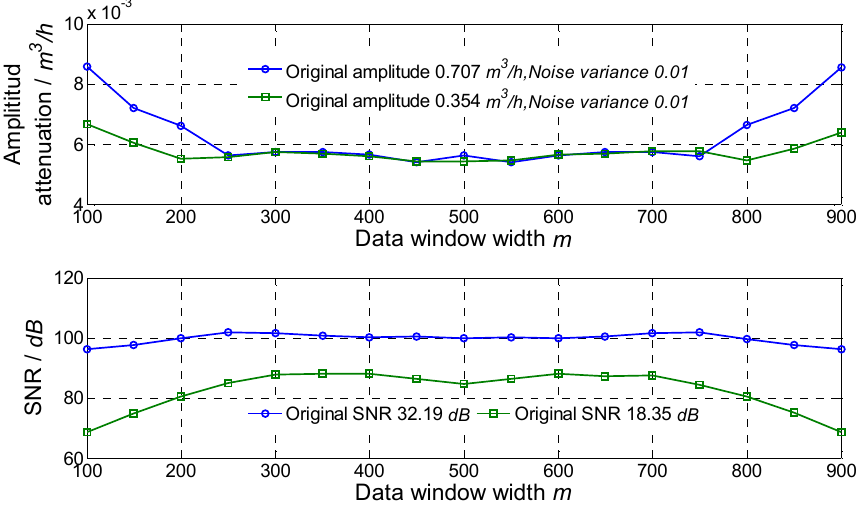
Figure 1. Result of using different data window widths.